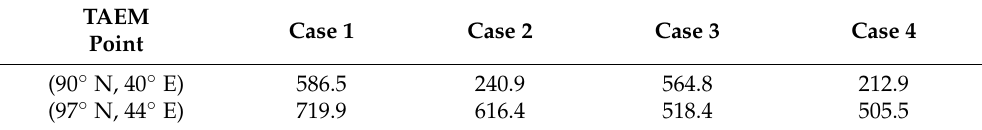
Table 7. The drop point error of high energy cases 1 − 4.